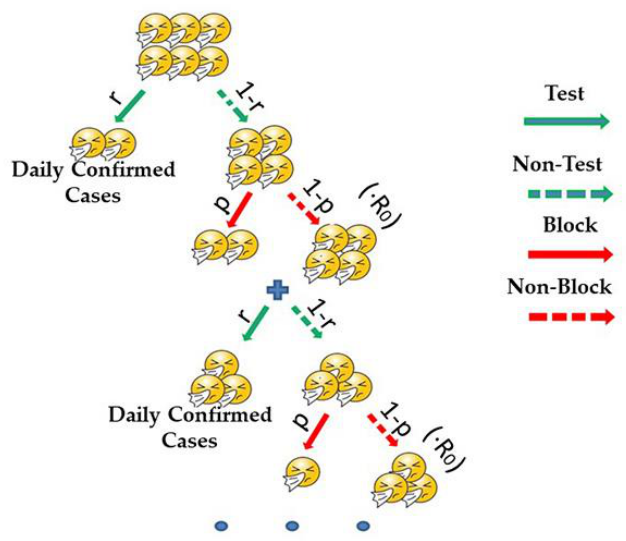
Figure 9. The transmission model of COVID-19 in Wuhan. Here, t represents the probability that an infected person will be tested. For example, if there are 100 infected people, but because of the limited test capacity, only 1000 people can be tested in one day, and 960 people tested are not infected, then only 40 infected people are tested; thus, at this time, t = 0.4. Therefore, there are 60 unconfirmed infected people at risk of infecting others with a probability of